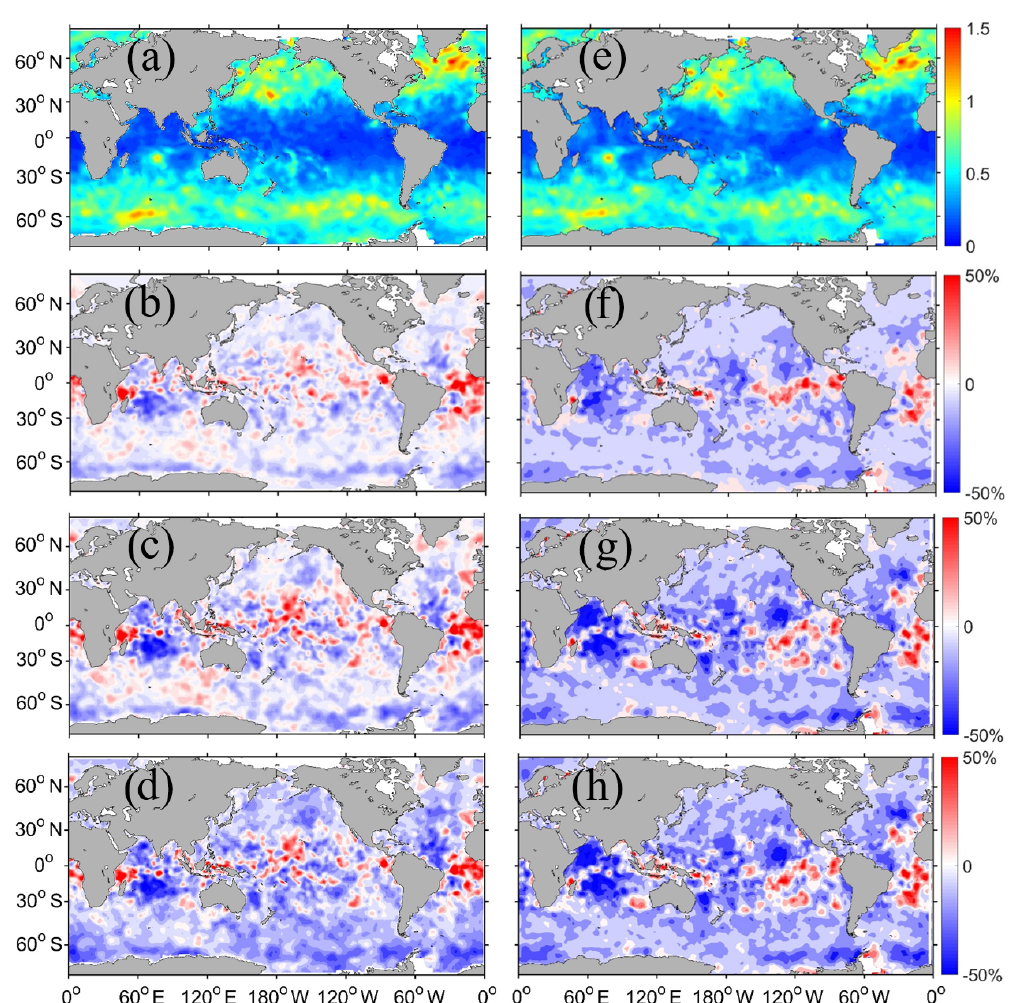
Figure 9. Distributions of corrected SWH RMSEs of the WW3 (a–d) and SWAN (e–h) model simulations (a, e) ; assimilations with Jason-2 (b, f) and with Jason-2, Jason-3 and SARAL (c, g) forced by the ERA-Interim wind as well as by a corrected wind (d, h) . All the results is corrected by the second bias correction method (named Bias correction2 in Fig. 8) (unit: